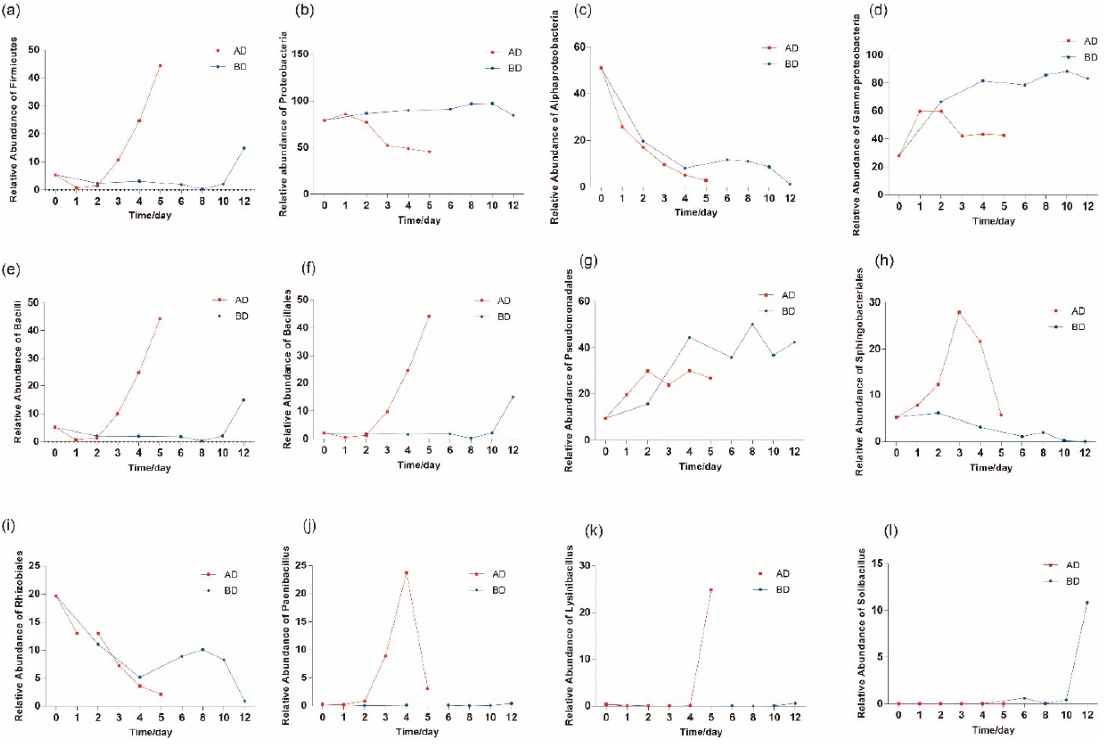
Figure 3. The bacterial species changed significantly with temperature and preservation time. ( a ) Firmicutes , ( b ) Proteobacteria , ( c ) Alphaproteobacteria , ( d ) Gammaproteobacteria , ( e ) Bacilli , ( f ) Bacillales , ( g ) Pseudomonadales , ( h ) Sphingomonadales , ( i ) Rhizobiales , ( j ) Paenibacillus , ( k ) Lysinibacillus and ( l ) Solibacillus . AD means 15 °C, BD means 30 °C.